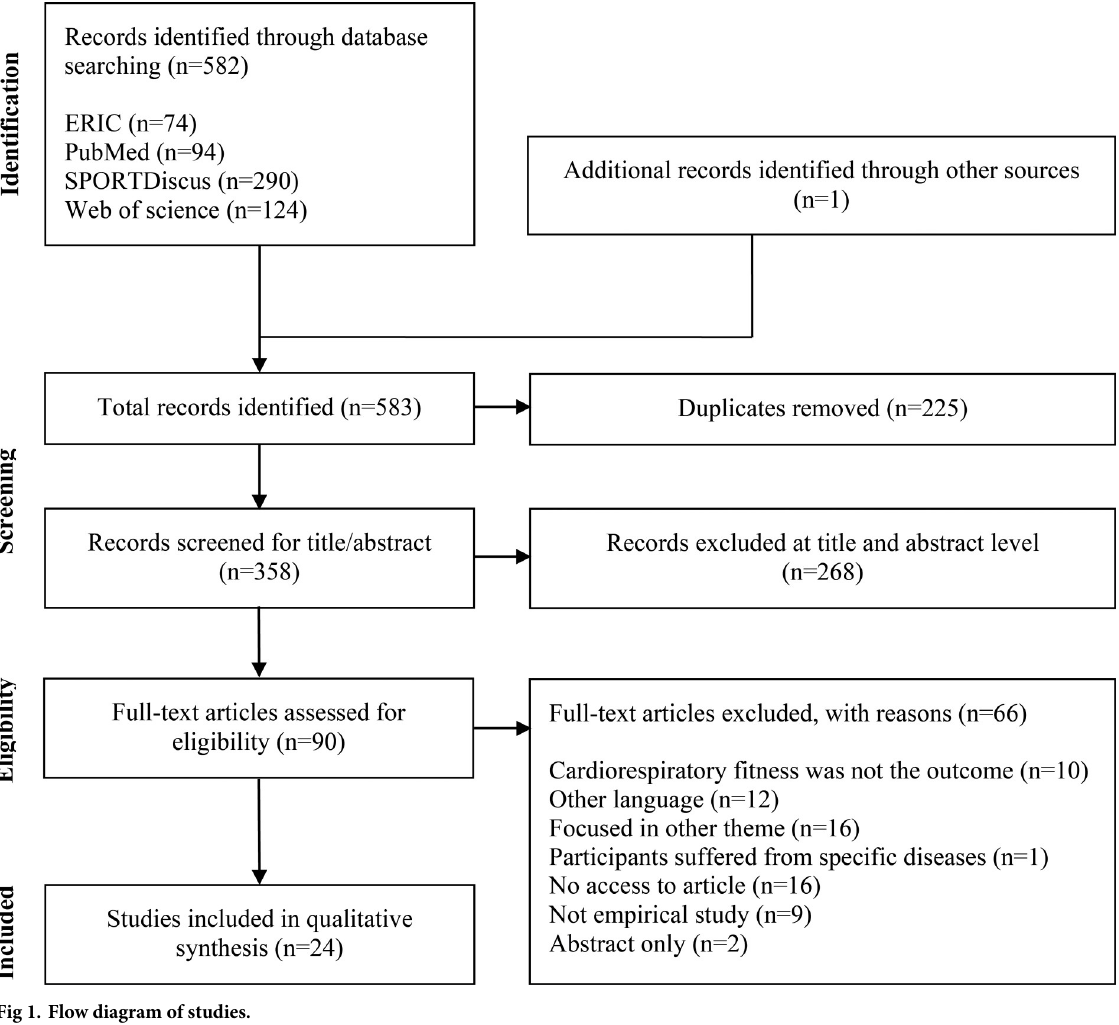
Fig 1. Flow diagram of